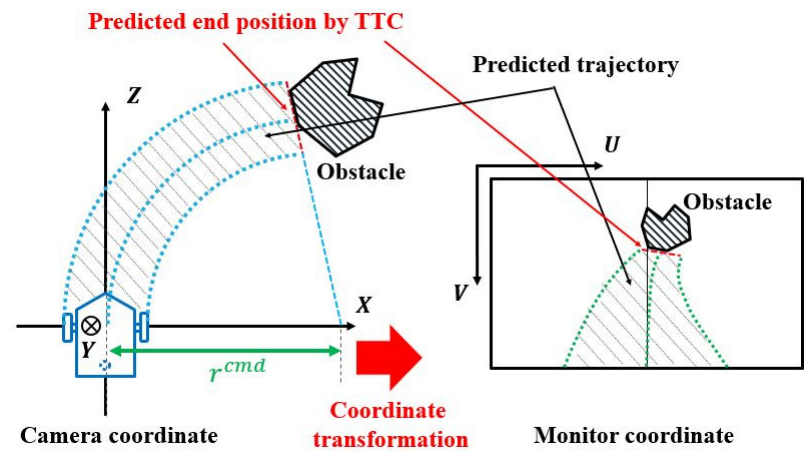
Figure 8. Predicted trajectory on the camera coordinate.